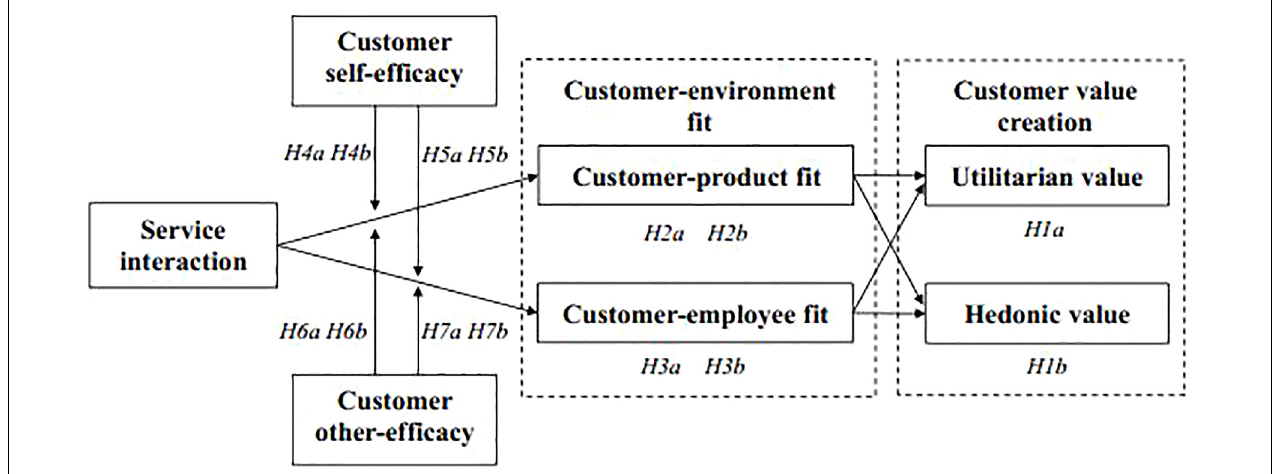
FIGURE 1 | Theoretical